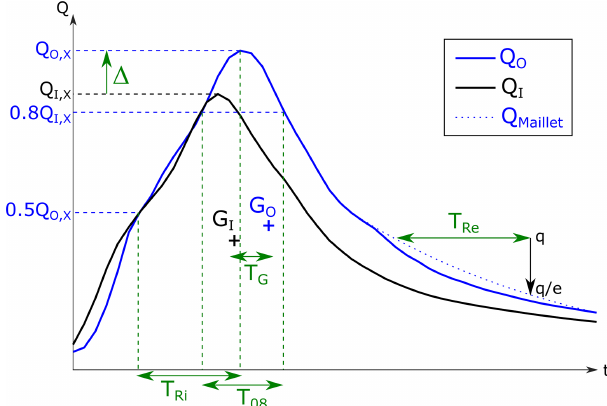
Figure 2. Storm hydrograph with characteristic times and discharge values. Q O , X and Q I , X are peak flows of outlet and inlet station hy- drographs Q O and Q I , respectively. T G is the elapsed time between the corresponding gravity centres G O and G I